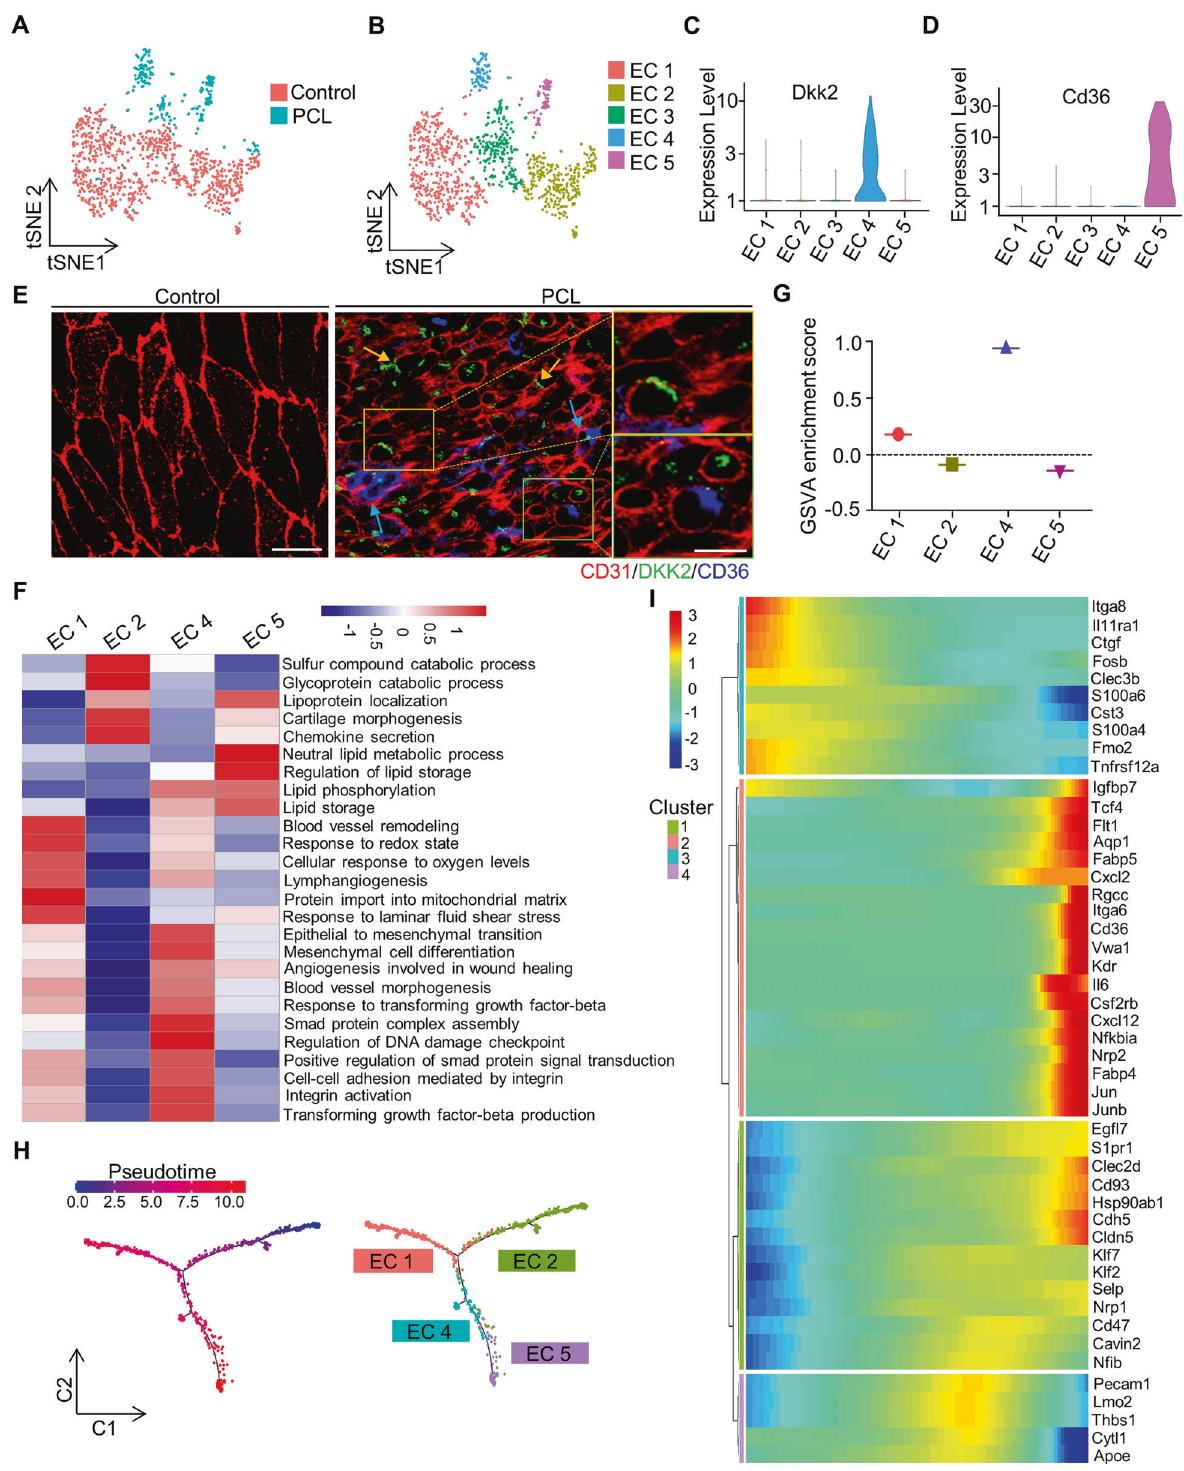
these clusters showed that the VSMC 3 (1387 cells) was a d- fl ow- associated subpopulation, while VSMC 1 (7332 cells) and VSMC 2 (2664 cells) were two clusters of normal VSMCs from the control group. Of note, Spp1 (secreted phosphoprotein 1) was highly expressed in VSMC 3 ( P = 0 by Wilcoxon rank-sum test), which is an osteoblastic marker. Thus, VSMC 3 can be referred to as Spp1 hi